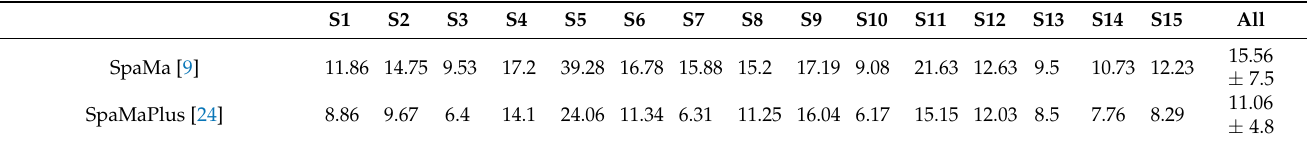
Table 2. Comparison of the accuracy of the 5 most promising variants of the solution presented in this paper to the algorithms from the literature on the large PPG-DaLia dataset as MAE (bpm). The heart rate measurements were recorded every 2 s. Each LSTM network was trained for 60 epochs on the training dataset described in Section 3 of this